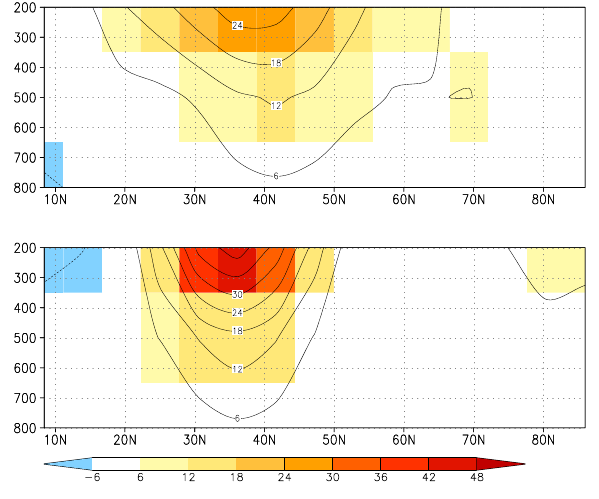
Fig. 6. Zonally averaged zonal velocity (ms − 1 ) for the control sim- ulation (upper panel), and the data assimilated experiment (lower panel). The zonal velocity is averaged over the North Atlantic sec- tor (60 ◦ W, 40 ◦ E) and averaged over the December–February pe- riod. Both contours and colourbar denote zonally averaged zonal